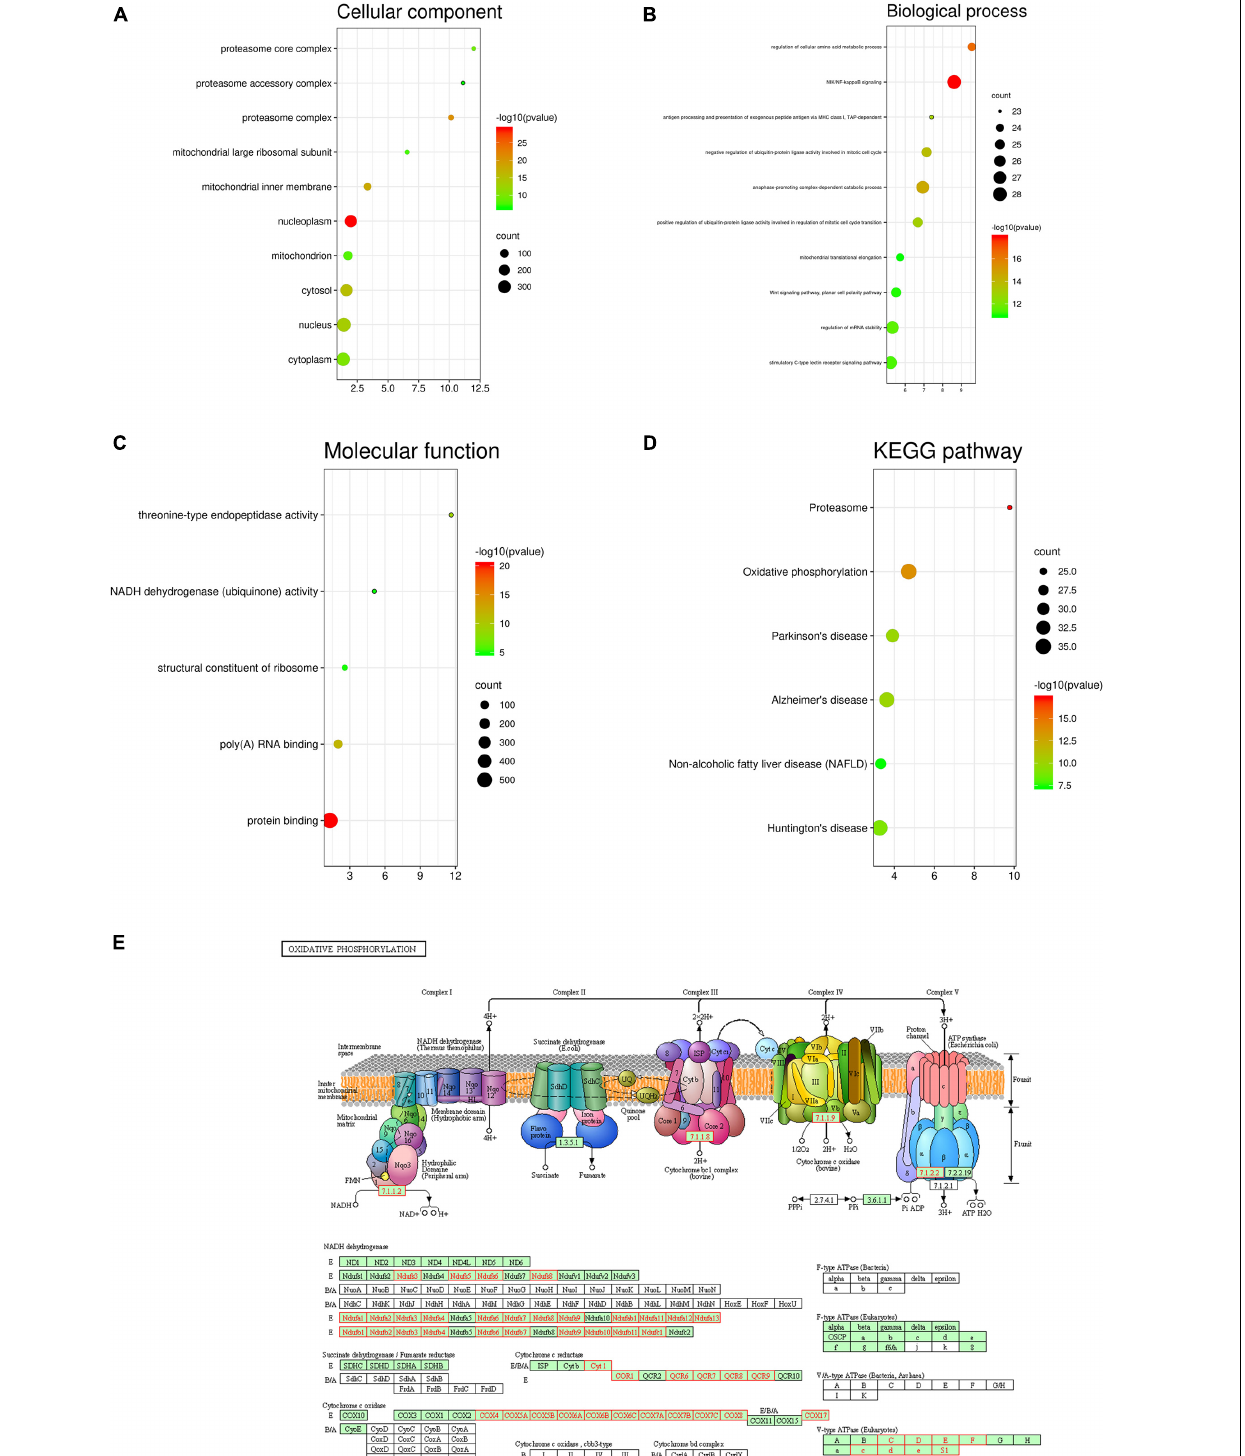
Frontiers in Genetics |